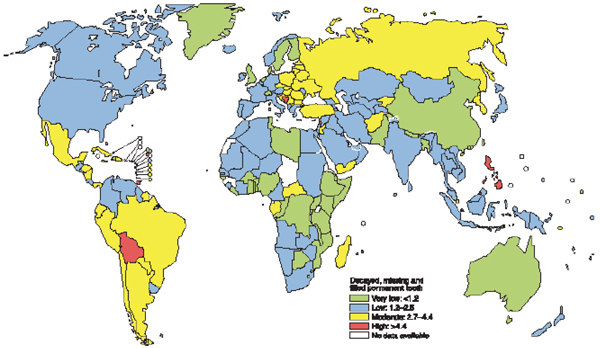
Dental caries levels (DMFT) of 12-year-olds worldwide. World Health Organization [2].